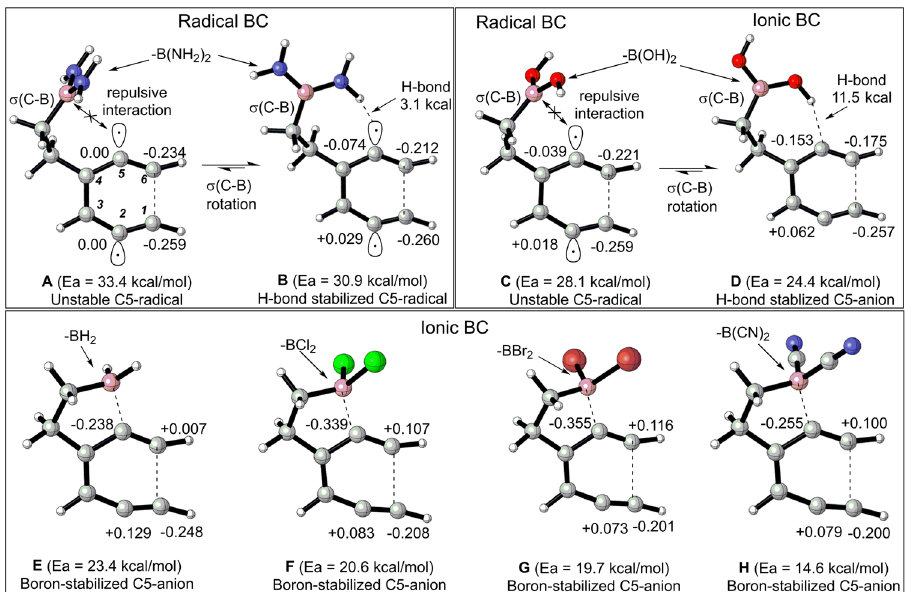
Fig. 8 B3LYP/LANL2DZ-optimized transition state geometries of substrates containing electronically diverse boryl groups. Structures A and B correspond to non hydrogen bonding and hydrogen bonding transition states in -B(NH 2 ) 2 substituted substrates respectively, Structures C and D correspond to non hydrogen bond and hydrogen bonding transition states in -B(OH) 2 substituted substrates respectively. Structures E , F , G , and H correspond to the transition states of substrates containing -BH 2 , -BCl 2 , -BBr 2 , and -B(CN) 2 groups respectively. The values re fl ect the NBO charges at C1, C2, C5, and C6